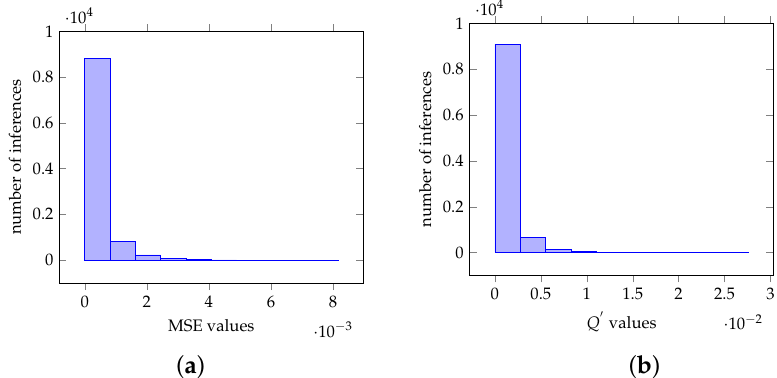
Figure 6. Values obtained from imagenet image ResNet-50 net classification for 1000 classes. ( a ) Histogram of the MSE values. ( b ) Histogram of the Q (cid:48)